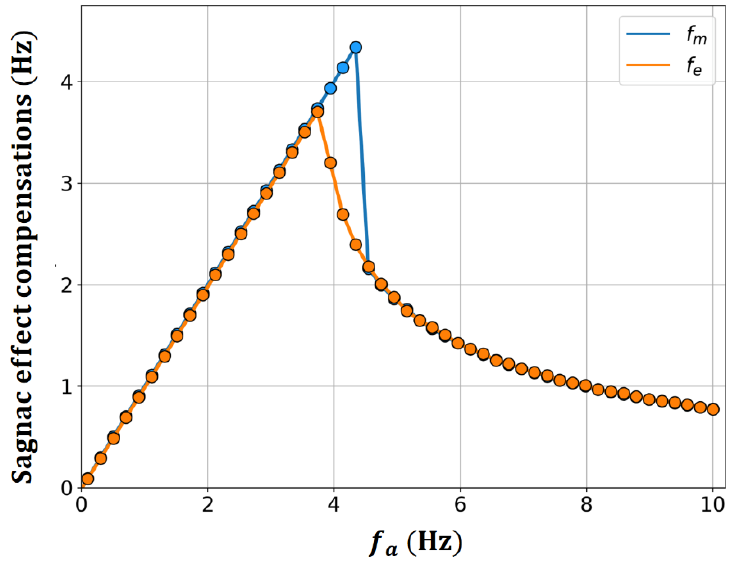
Figure 4. Sagnac effect compensations with 𝒇 𝒎 and 𝒇 𝒆 as a function of 𝒇 𝒂 = 𝒂/𝟐𝝅 .